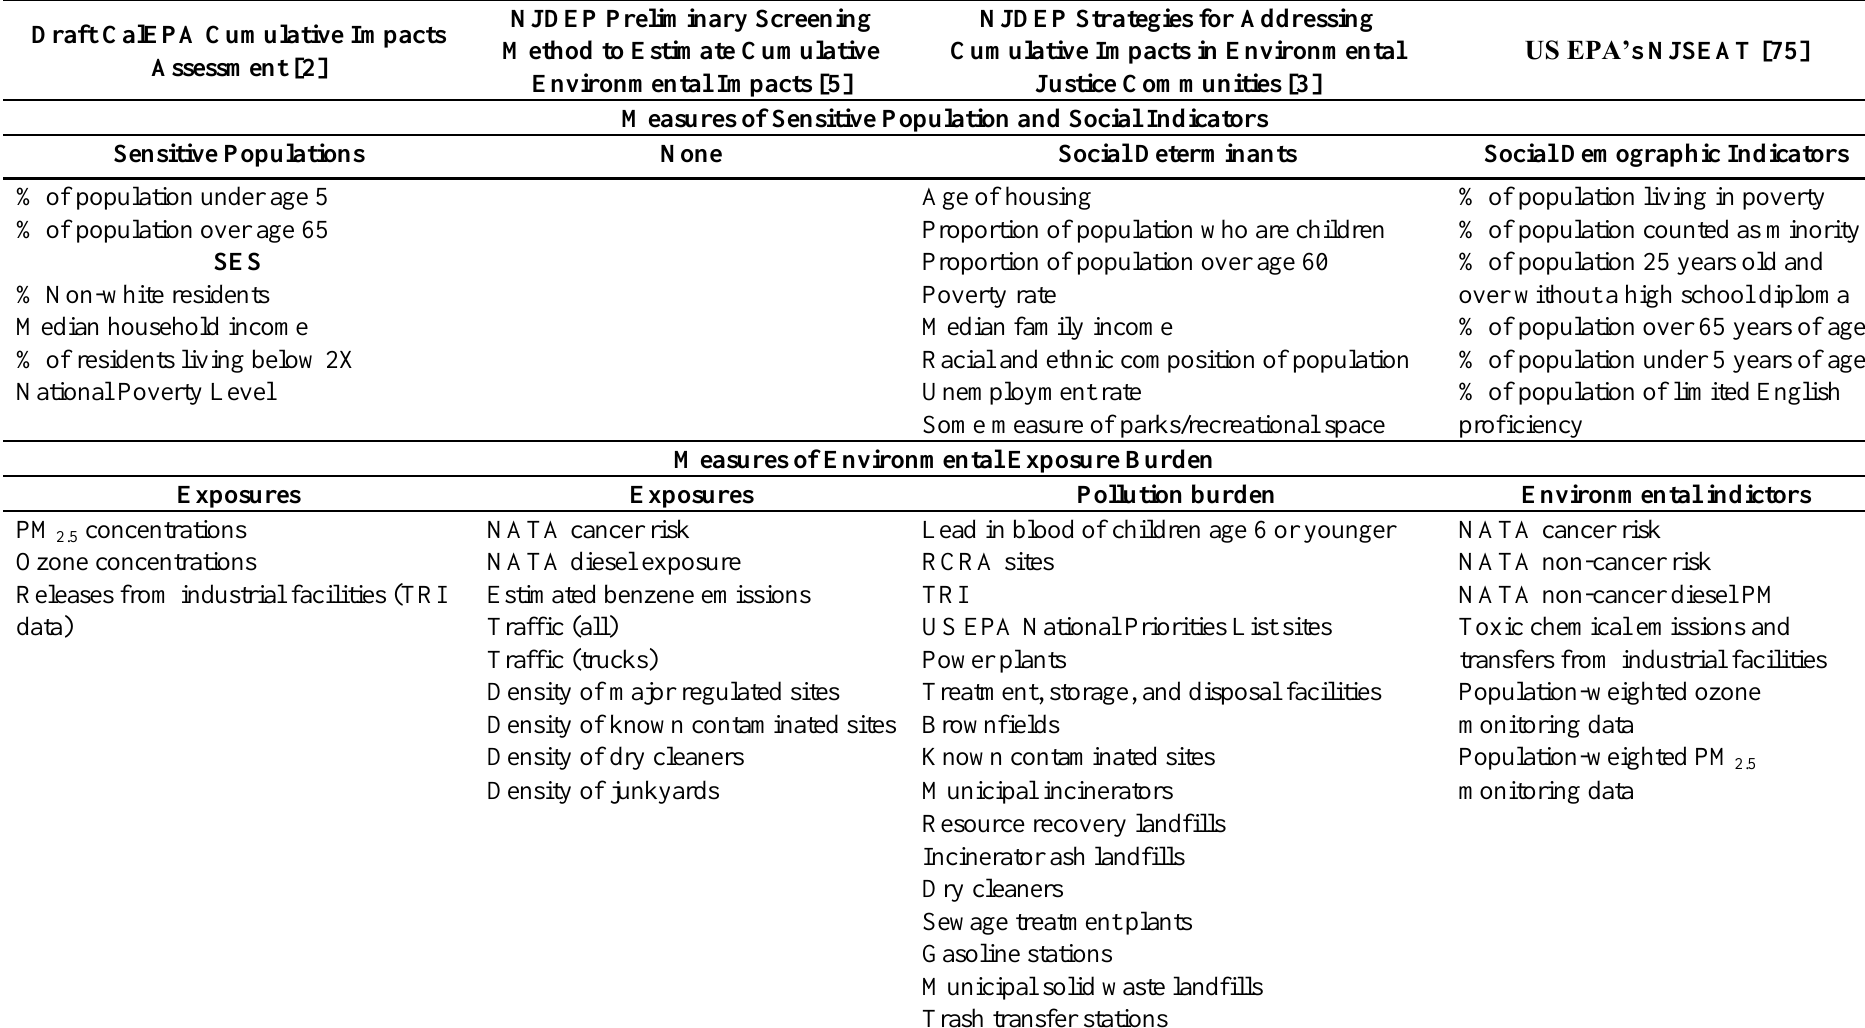
Table 3. Indicators in current tools to assess potential cumulative risk in